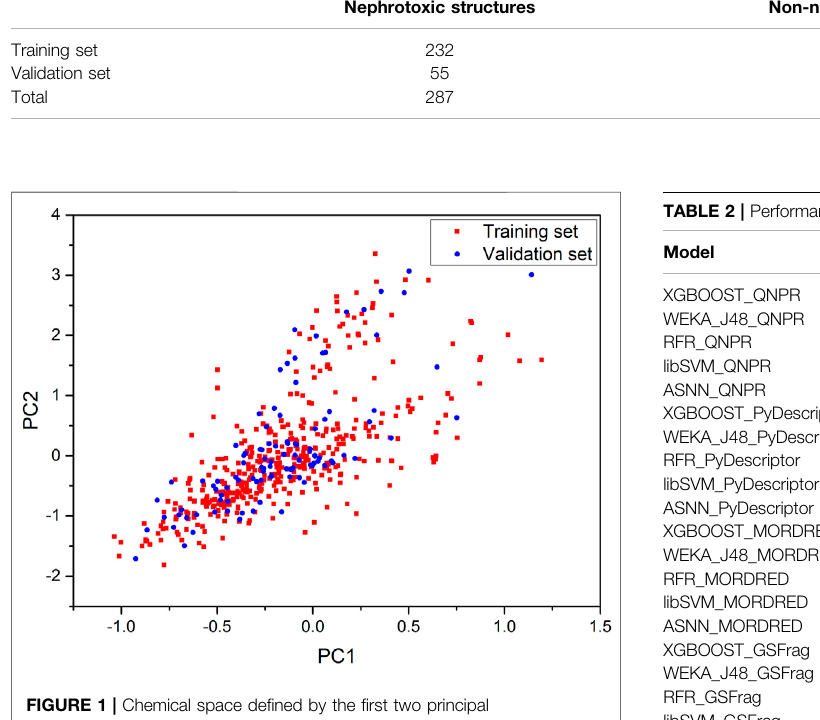
FIGURE 1 | Chemical space de fi ned by the fi rst two principal components of CDK descriptors. Red squares stand for the training set, blue circles stand for the validation set.